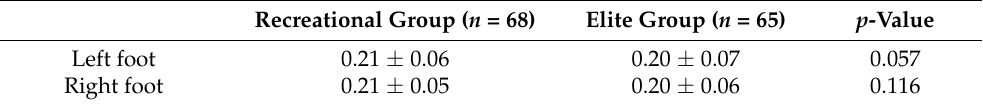
Table 2. Bipedal arch indices of elite and recreational badminton players.